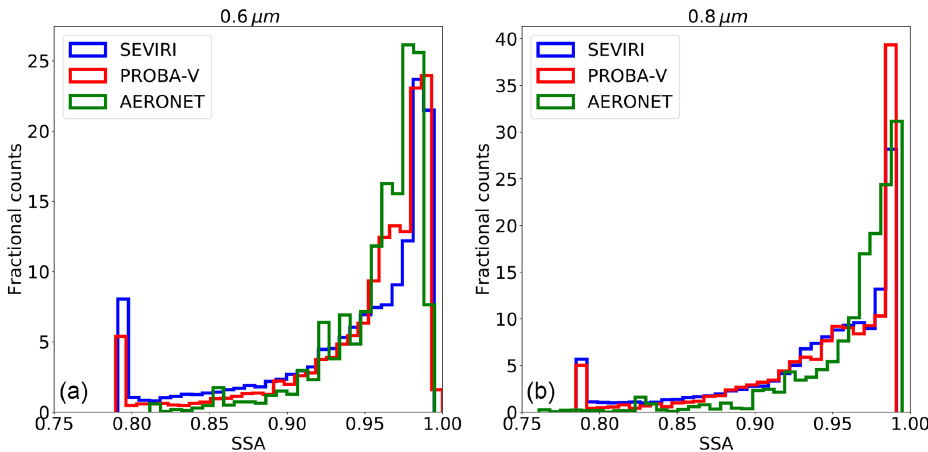
Figure 16. SSA distributions at 0.6µm ( a ) and 0.8µm ( b ) for AERONET (green), and CISAR applied to SEVIRI (blue) and to PROBA-V (red).